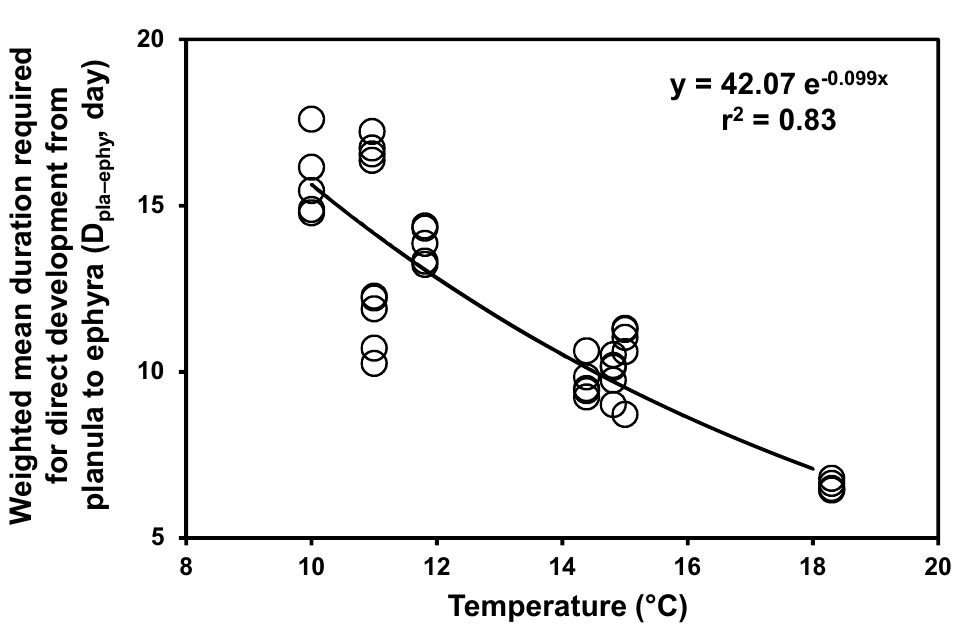
Fig 6. Duration required for direct development from planula to ephyra in relation to temperature.